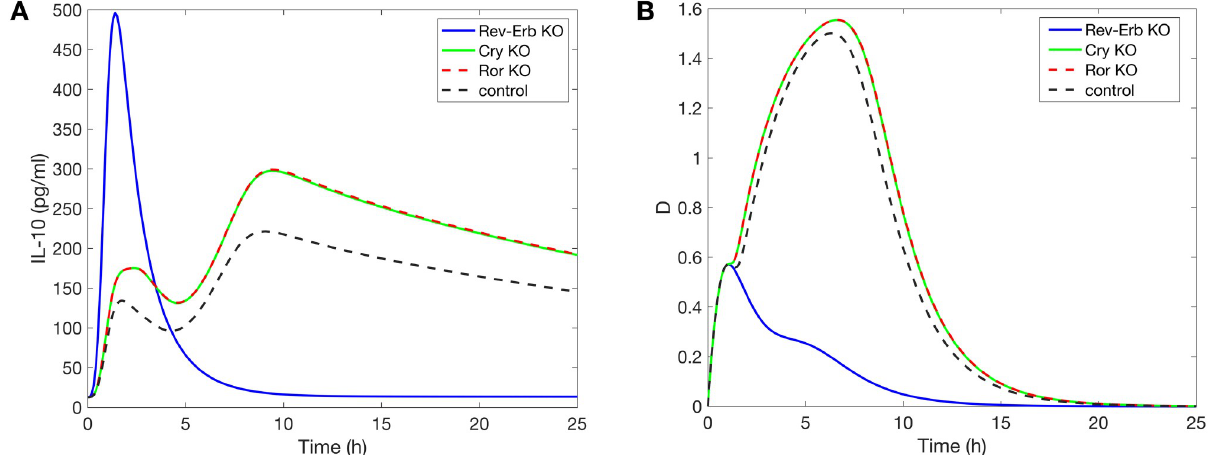
Fig 7. Knockout experiment at CT12. Model simulations of the time course of IL-10 (A) and the damage marker (B) in response to endotoxin dose 3mg/kg administered CT12. Three scenarios are simulated: Rev-Erb KO, Cry KO and Ror KO.